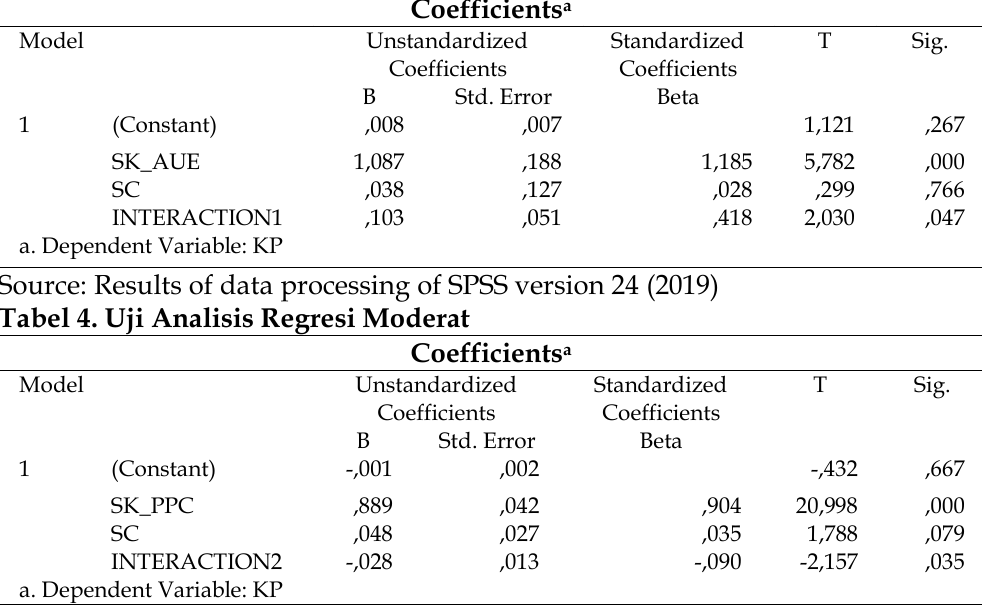
Table 3. Moderate Regression Analysis